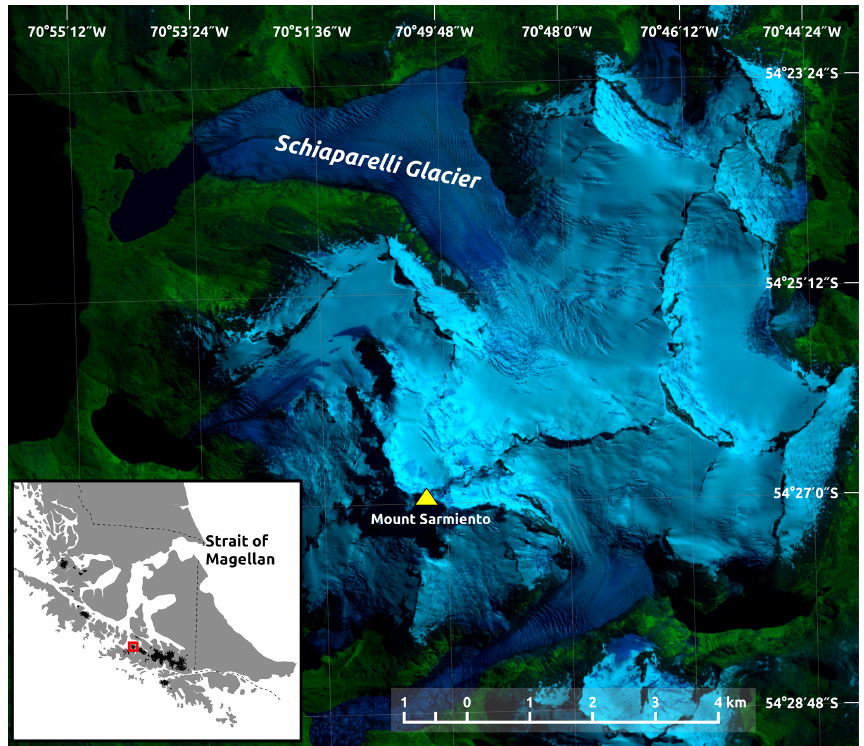
Figure 1. Schiaparelli Glacier location. The proglacial lake to the left (west) of Schiaparelli Glacier is named Lago Azul. The inset shows the southernmost tip of South America where Tierra del Fuego is south of the Strait of Magellan; the black areas depict the glaciated areas of Cordillera Darwin. Image: Sentinel 2 RGB − 84, 4 February